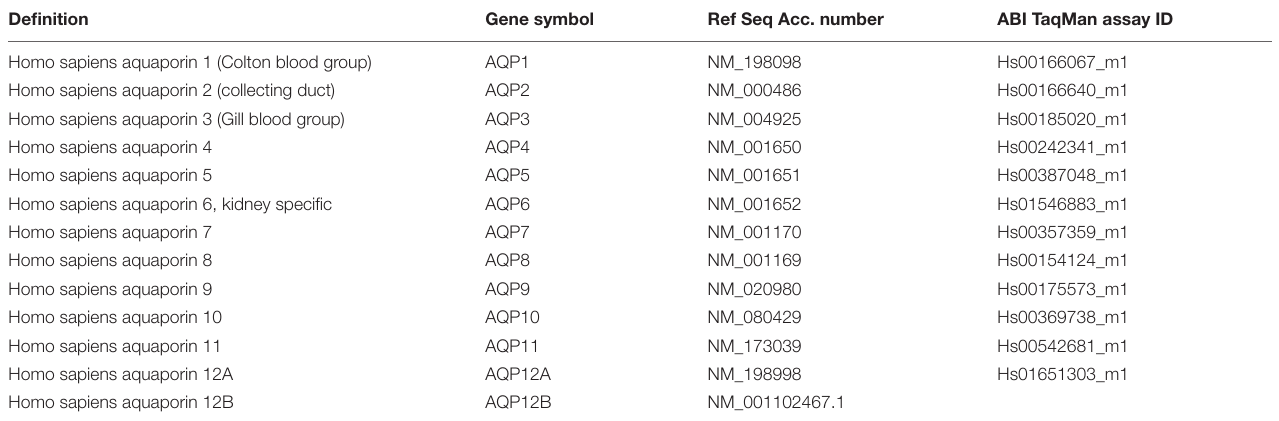
TABLE 1 | TaqMan assays used for the investigation of AQP expression.